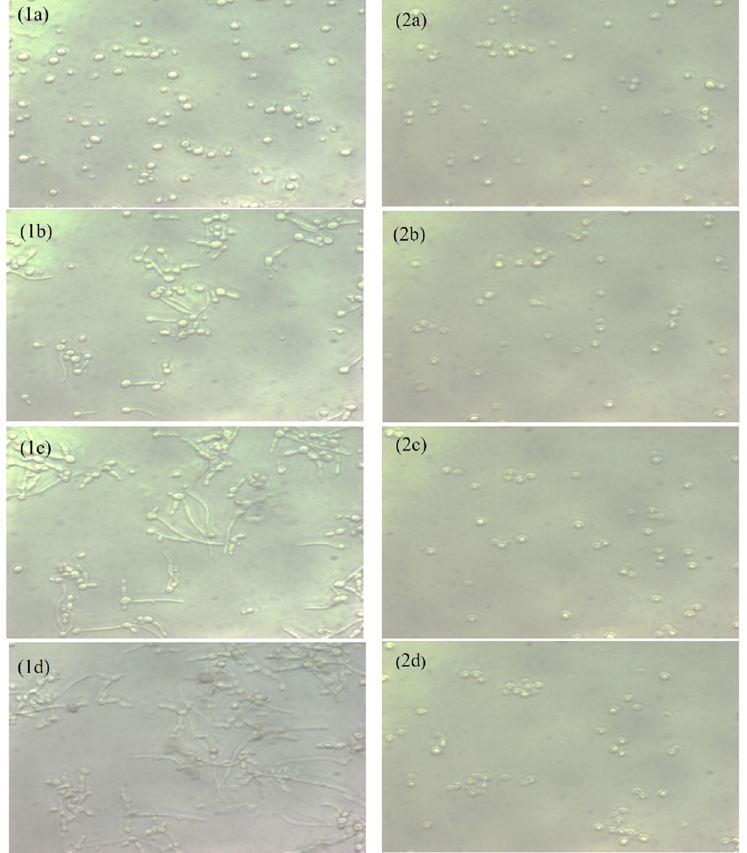
Figure 2. Effect of Capsaicin (MIC) on the hyphae growth of C. albicans (Endo ‐ 902). The live cells photograph was recorded by the cell observer microscope (20×). The photograph of untreated cells ( 1a – 1d ) and treated cells ( 2a – 2d ) were recorded at three ‐ hour time points, respectively.